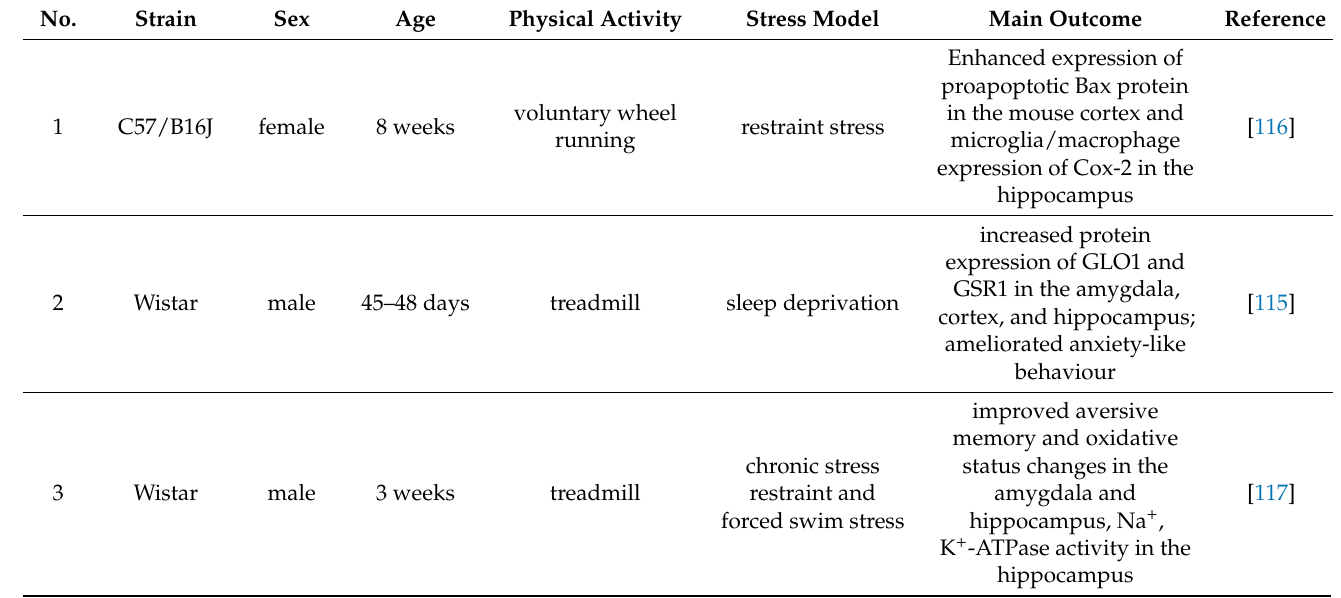
Table 5. Summary of animal research focusing on oxidative